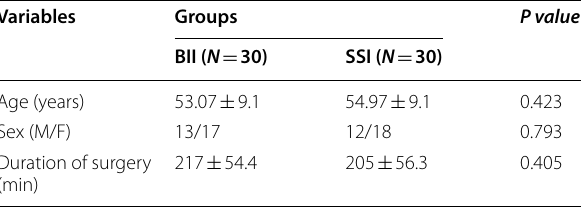
Data are presented as count and mean significant. BII Bolus-insulin infusion group, SSI Sliding scale of insulin group, M